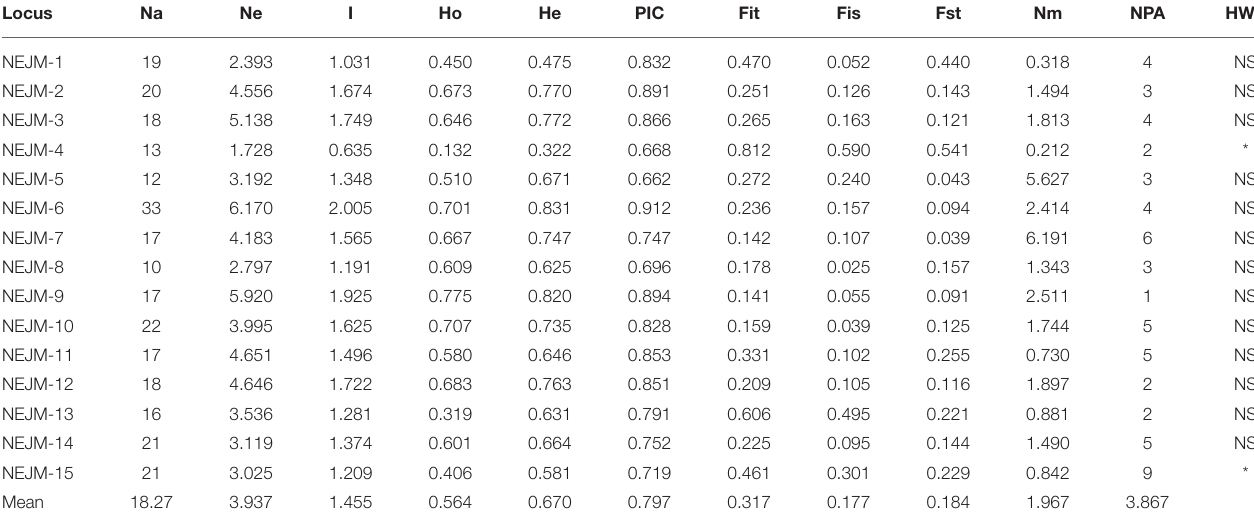
TABLE 3 | EST-SSR primer polymorphisms of J. mandshurica . Locus